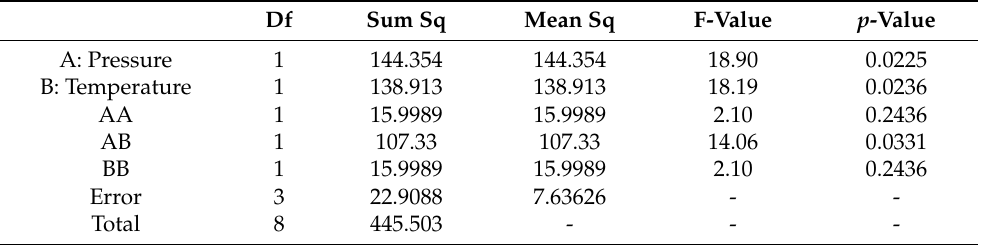
Table 2. ANOVA table showing the swelling of PLA filaments under supercritical conditions.